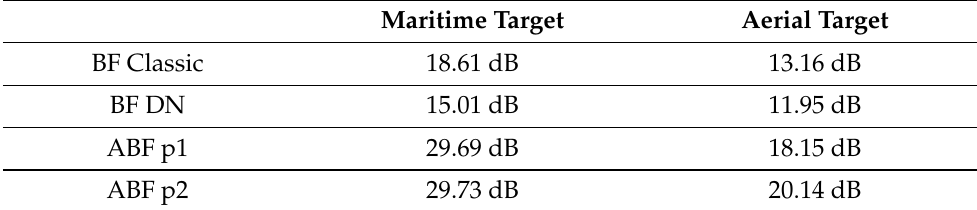
Table 2. Mean SNR of targets for each proposed solutions along all the